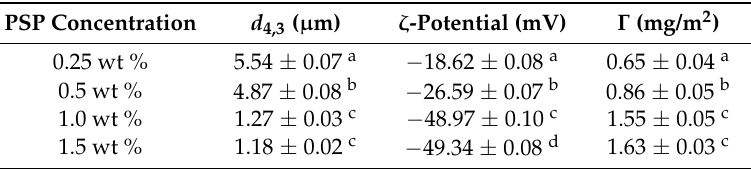
Table 1. Emulsion characteristics, including d 4,3 , ζ -potential and interfacial protein concentration ( Γ ) of emulsions with different protein concentration.